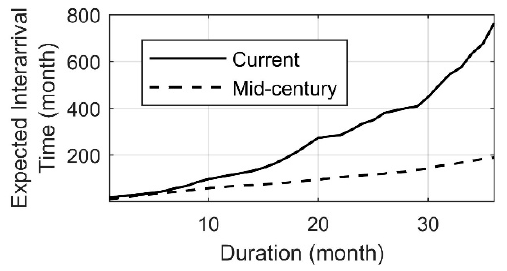
Figure 11. Expected interarrival time (month).